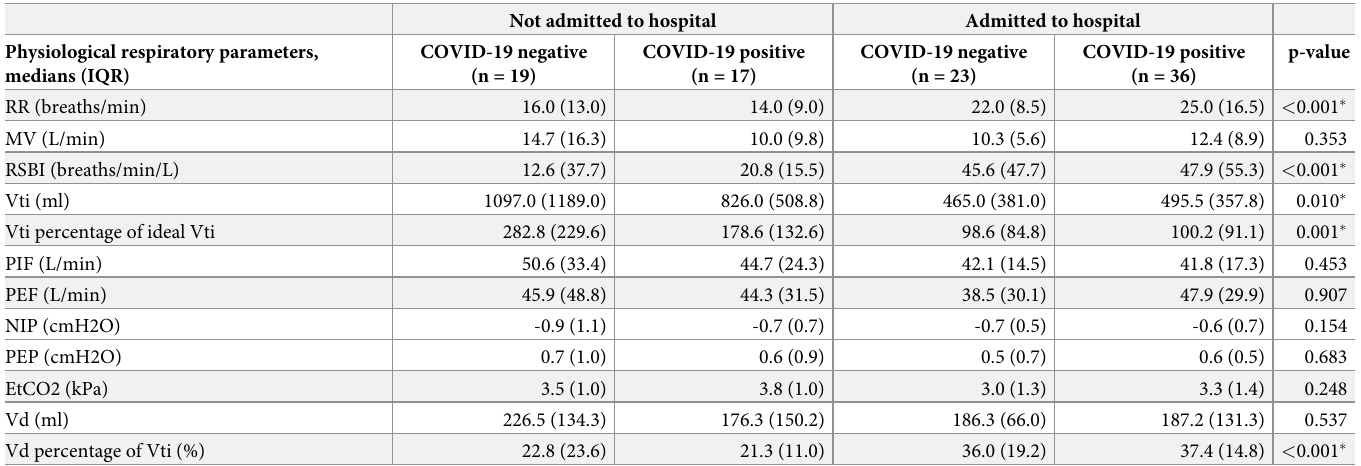
Table 5. Physiological respiratory parameters, hospital admissions and